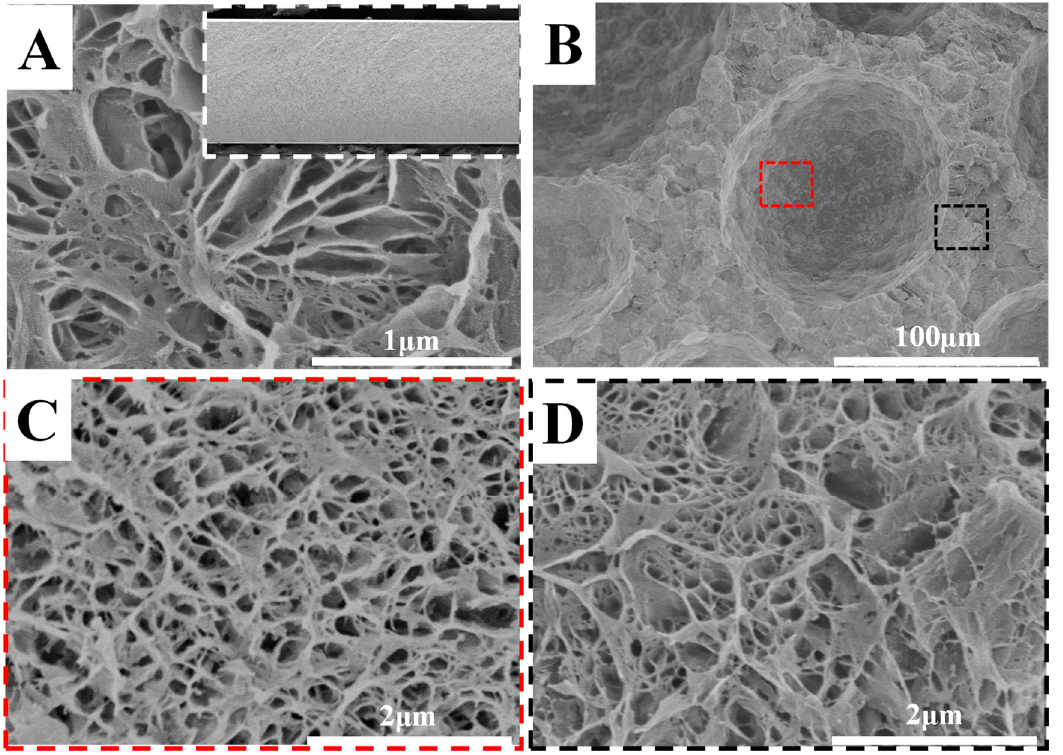
Figure 5. SEM images of the fracture surface of the reference ( A ), PVDF HPMs (2–20) ( B ) and images with higher magnifications ( C , D ). Inset in ( A ) shows the whole cross-section of reference. The red and black dash boxes represent the magnified images at the indicated position.